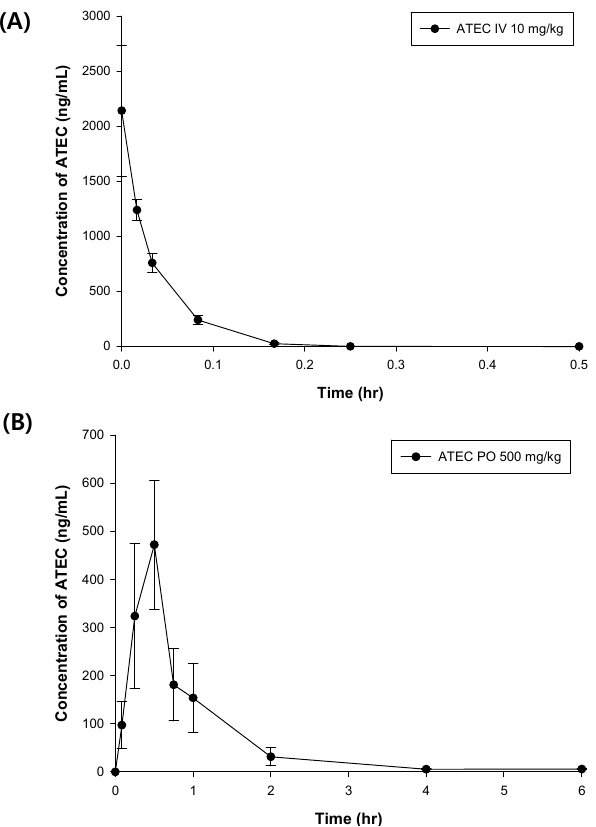
Figure 3. Mean plasma concentration–time profile of ATEC (A) after intravenous (i.v.) administration of 10 mg/kg of ATEC to rats ( n = 6) and (B) after oral (p.o.) administration of 500 mg/kg ( n = 6). Data are expressed as mean ± SD. The initial concentrations in the i.v. administration were estimated and indicated. Table 3. Pharmacokinetic parameters after i.v. and p.o. administration of ATBC to rats. Parameter